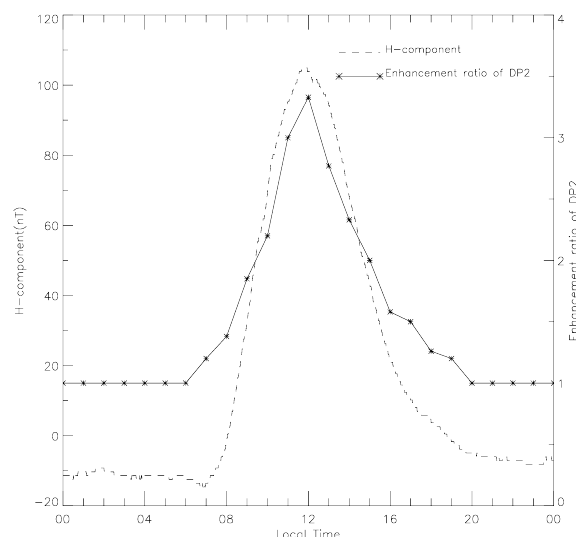
Fig. 5. African sector, results of the year 1993: Variation of DP2 enhancement ratio average at NIE (solid line) and the S r (H) average (dotted line). The correlation coefficient is